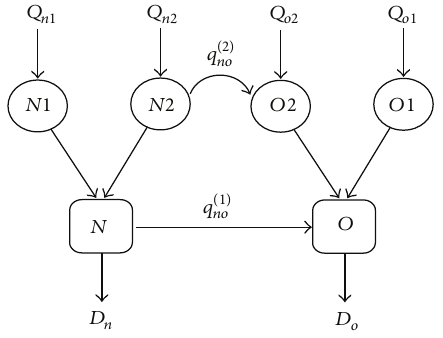
Figure 1: Notation sketch